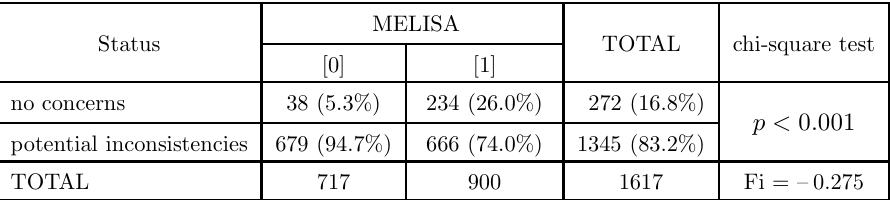
Table 3. Relationship between the occurrence of the “melisa” ingredient and its